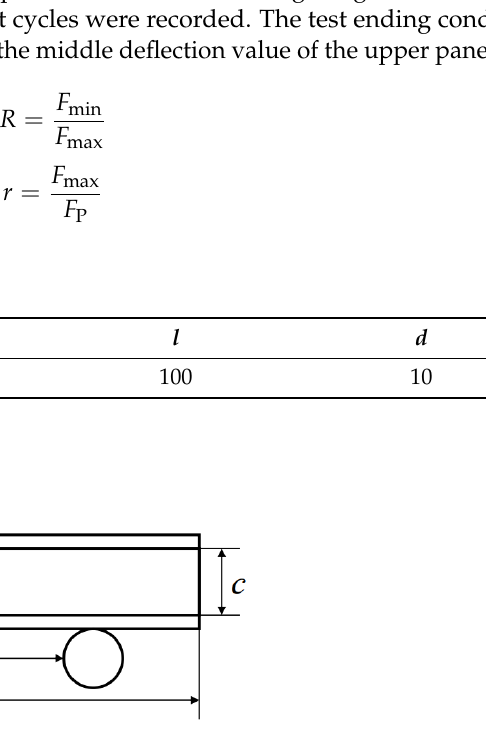
Figure 2. The position relationship between the three-point bending fixture and the sample.